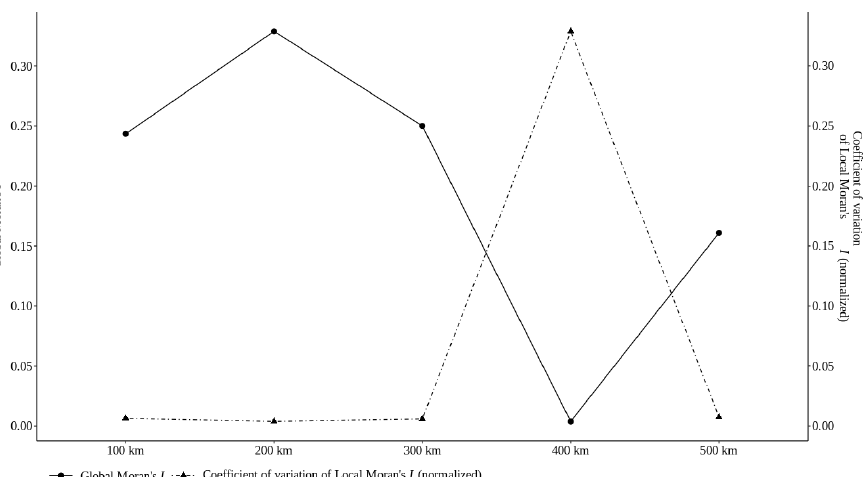
Figure 4. Trade-off between the global indicator of spatial association (Global Moran’s I ) and the overall degree of structural (in)stability (coefficient of variation of Local Moran’s I normalized by scaling between the minimum and maximum values of the Global Moran’s I coefficients. Both global and local spatial statistics were computed for a row-standardized spatial weights matrix based on first-order rook